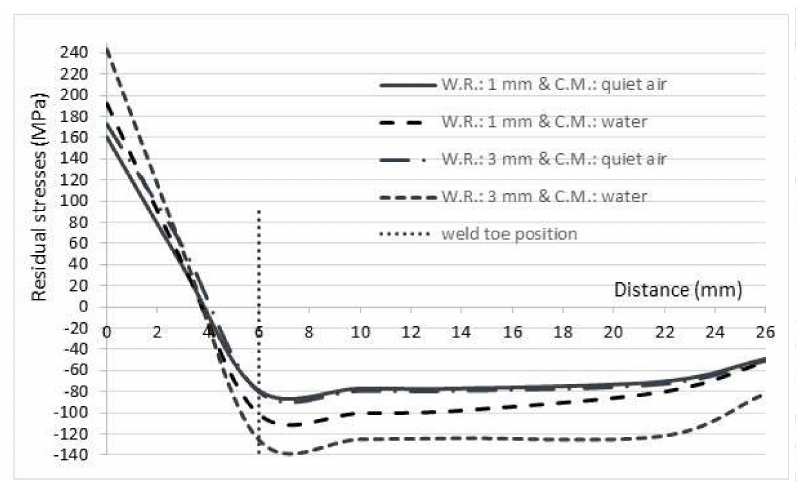
Figure 10. Residual stress profile on transverse direction to weld beat.